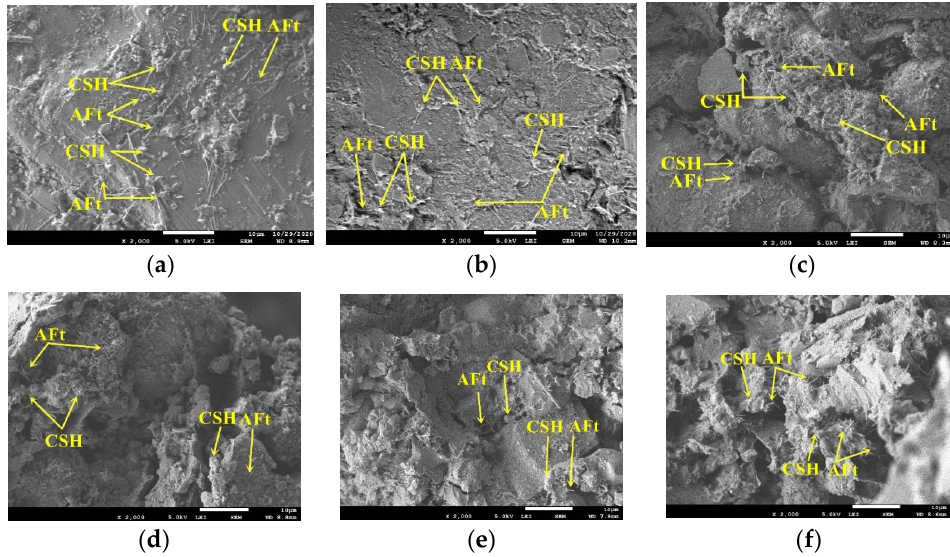
Figure 8. SEM images of specimens at different freeze–thaw cycles (×2000 times). ( a ) N = 0, ( b ) N = 1, ( c ) N = 3, ( d ) N = 6, ( e ) N = 9, ( f ) N = 12.